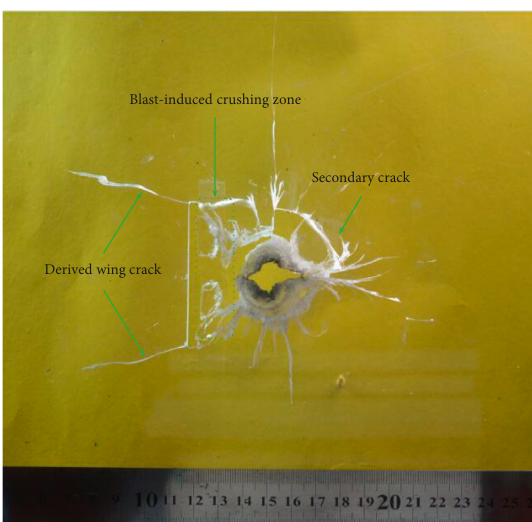
Figure 25: Blasting effect drawing for case SN I -3.